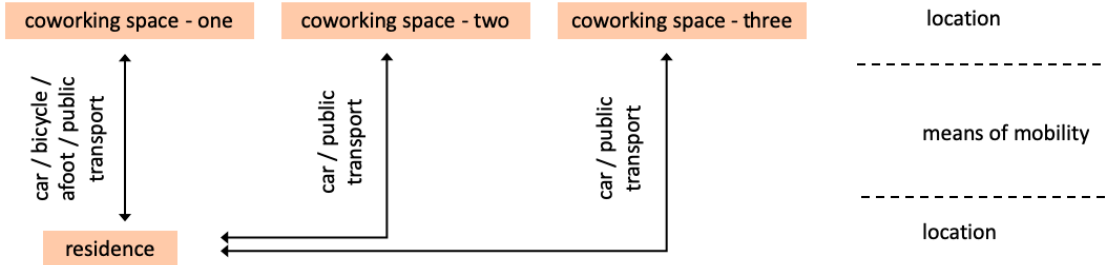
Figure 4. Conjunction of workplace and residence by means of transportation.